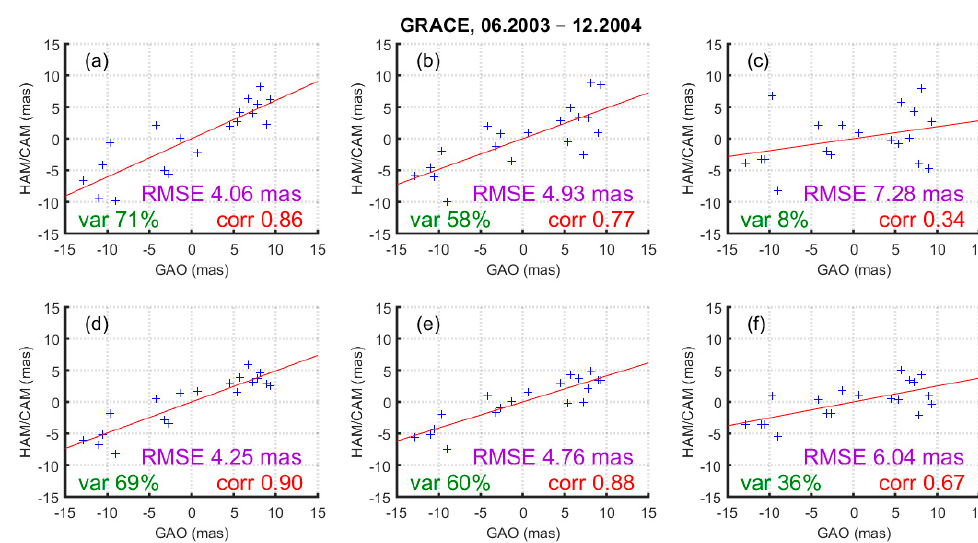
Figure 7. Scatter plots showing the relationship between the χ 2 component of GAO and HAM/CAM from ( a ) CSR GSM, ( b ) JPL GSM, ( c ) GFZ GSM, ( d ) CSR TWS, ( e ) JPL TWS, and ( f ) GFZ TWS. The red line was fitted to the data points using the least squares method. The values in purple indicate the RMSE, the values in red (corr) indicate the correlation coefficients between series, and the values in green (var) indicate the relative explained variances. The considered time period is June 2003 to December 2004. Note that the critical value of correlation coefficient for 12 independent points and a 95% confidence level is 0.50, while the standard error of the difference between two correlation coefficients is 0.47. All the parameters were computed after removal of trends.